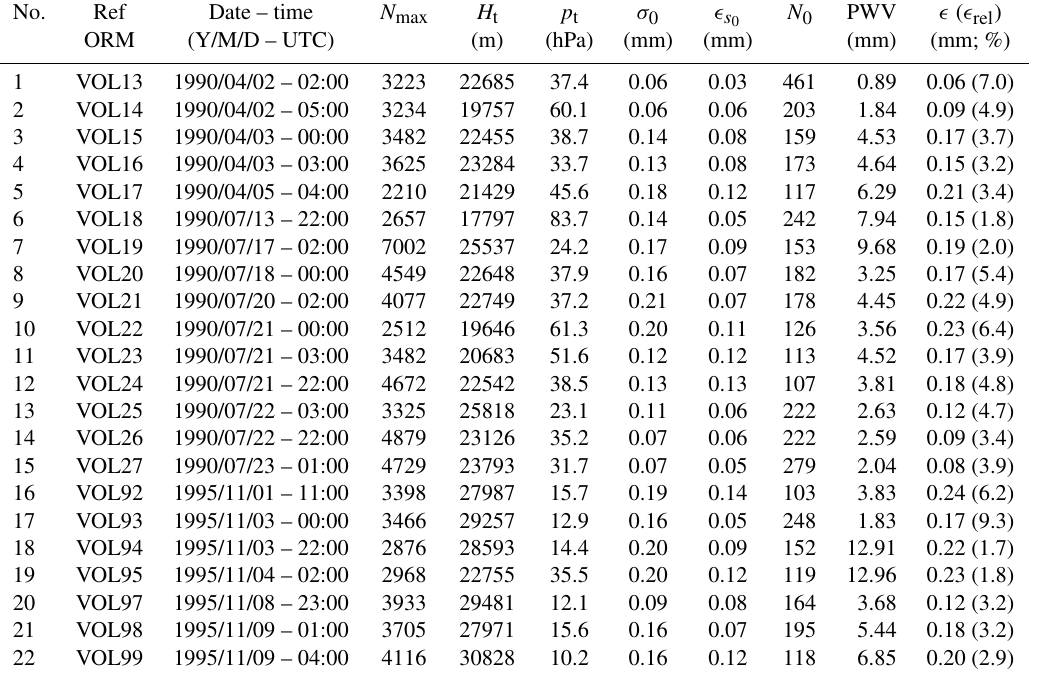
Table B1. PWV data and optimized error (cid:15) (see Eq. 19) for the radiosoundings at ORM. N max is the actual number of sampled levels; H t (m) and p t (hPa) are the top height and pressure reached by the balloon. The parameters σ 0 and (cid:15) s of the error (Eq. 21) and N 0 is the optimum number of levels (Eq. 20). The brackets in the last column are the relative errors (cid:15) rel .